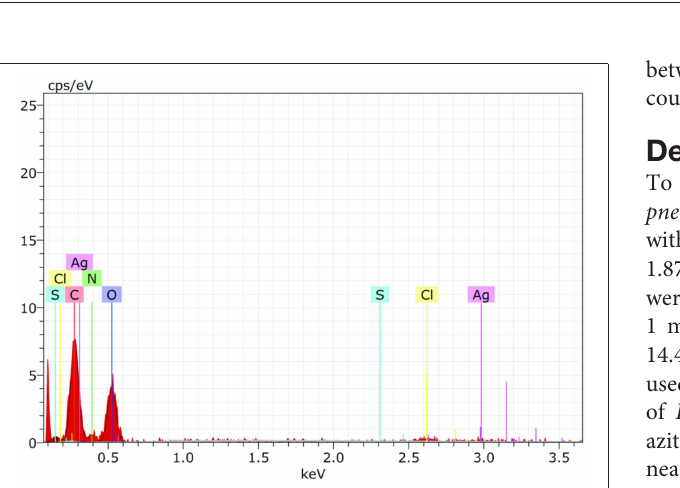
FIGURE 6 | XRD pattern of silver nanoparticles (AgNPs) formed by bombarding with monochromatic Cu radiation. The pattern proves the crystalline nature of nanoparticles with face centered crystal lattice as depicted by the plane of unit cell.